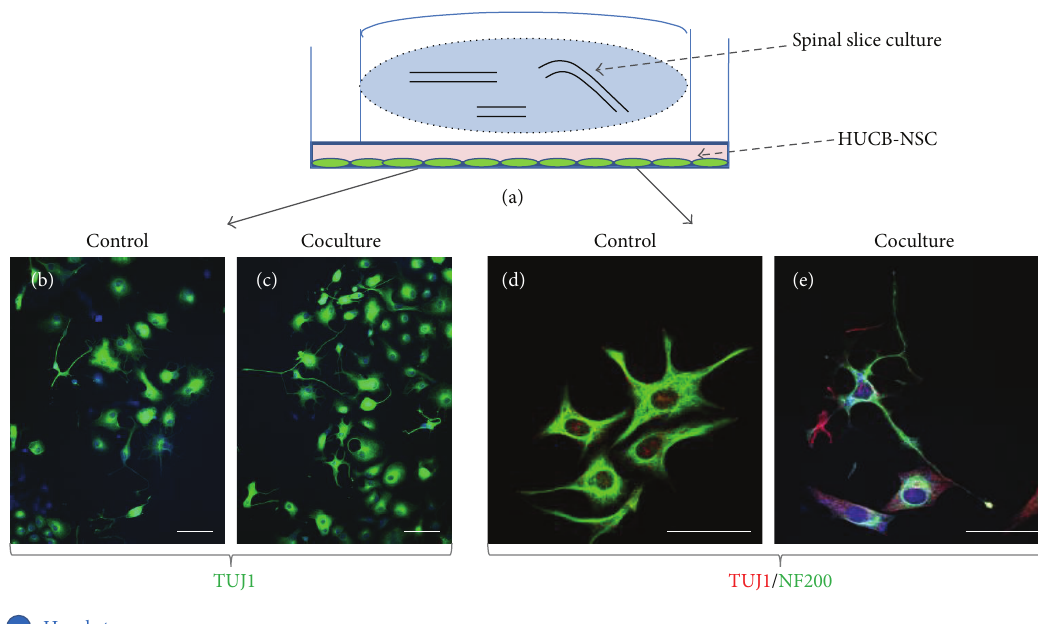
Figure 3: Cocultivation of HUCB-NSC with the spinal cord organotypic slice culture, an example of immunohistochemistry experiment. The cells growing in the 6-well plates were cocultivated with SCC placed on the membranes inserted into wells (a), without a direct cell-to-cell contact with the slices. HUCB-NSC seeded at the beginning of the experiment at the same density proliferated faster in the vicinity of SCC ((b)-(c)). Moreover, their morphology was more ramified and the observed TUJ1 expression was higher than that in the control ((d)-(e)). Cell nuclei (blue) were visualized by staining with Hoechst 33258. Scale bar corresponds to 50 𝜇 m.